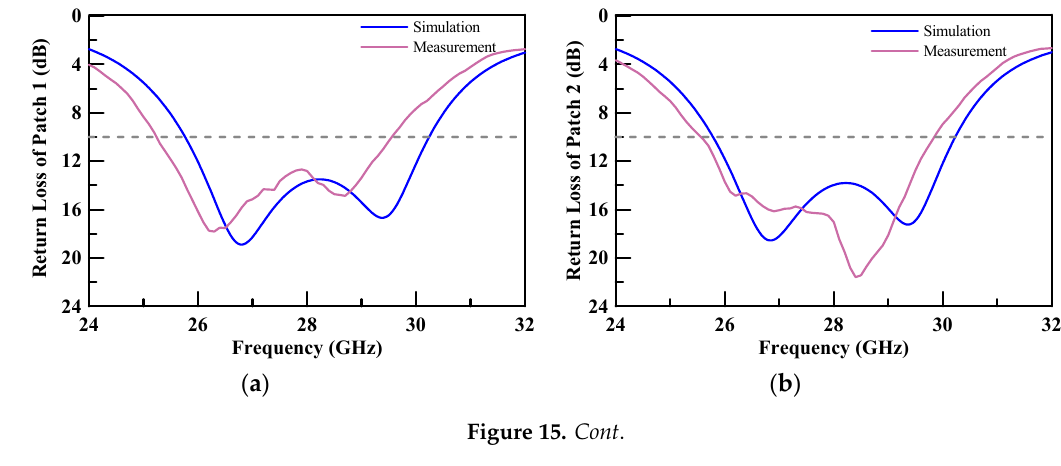
Figure 14. Photograph of the array antenna (2 × 2).